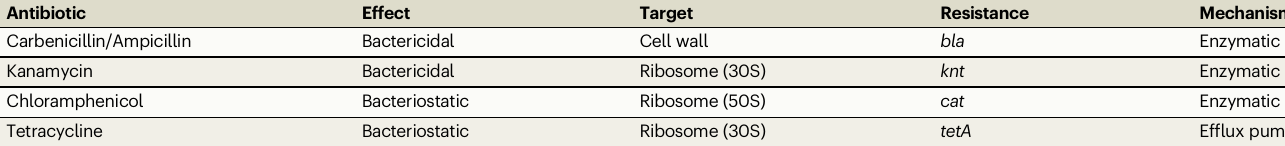
Table 1 | Summary of antibiotics and corresponding resistance genes used in this work